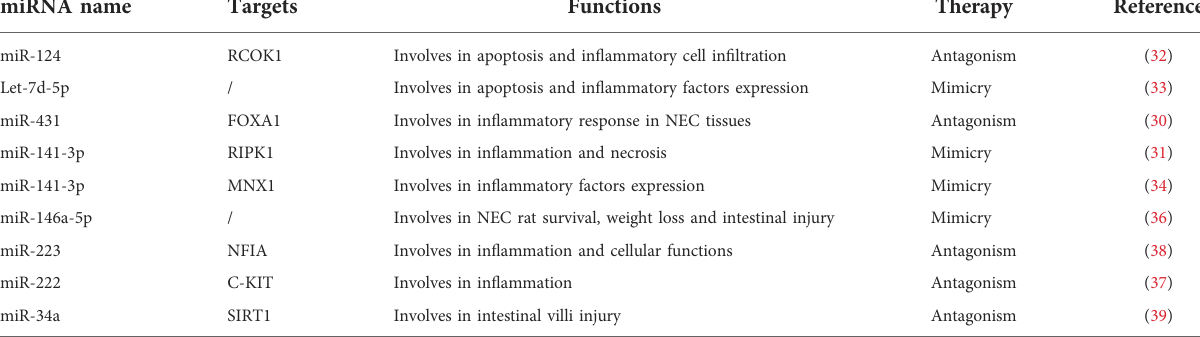
TABLE 3 Summary of potential therapeutic miRNAs in NEC. miRNA